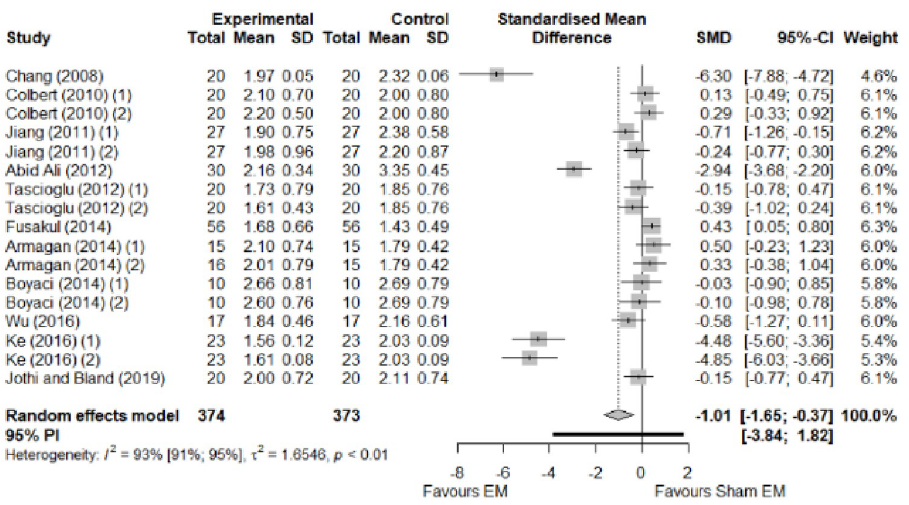
Fig 3. Analysis—Electrophysical modalities versus placebo (symptoms severity). Studies with more than two intervention groups (different modalities, treatment doses, or symptom classification) were numbered as (1) and